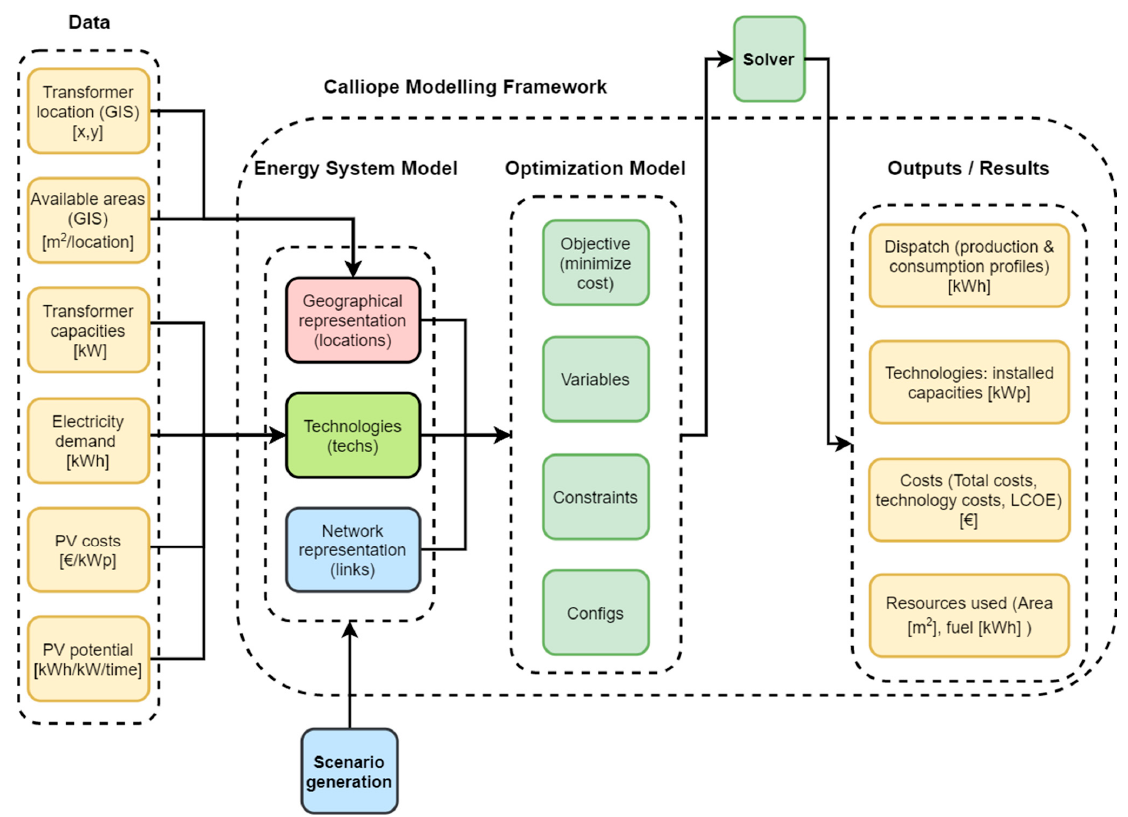
Figure 1. High-level view of the modeling workflow used, comprising the interconnection between data and the modeling framework.